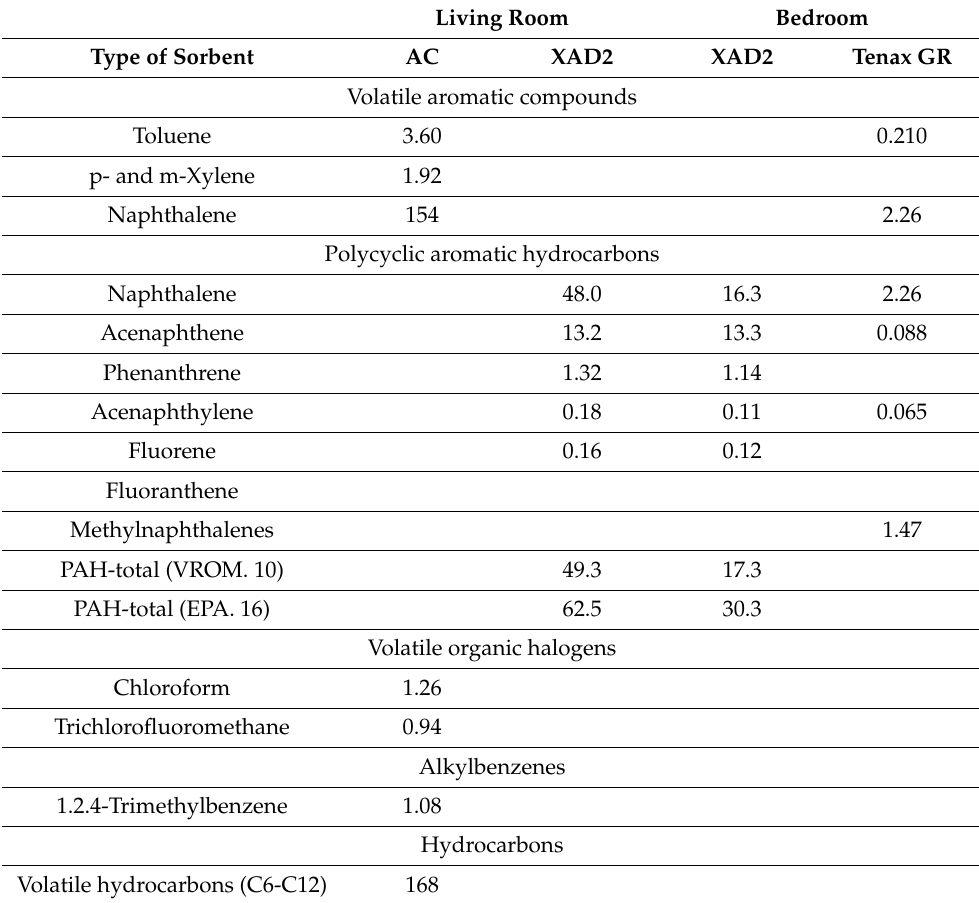
Table 3. VOC and SVOC concentrations ( µ g/m 3 ) in the air.